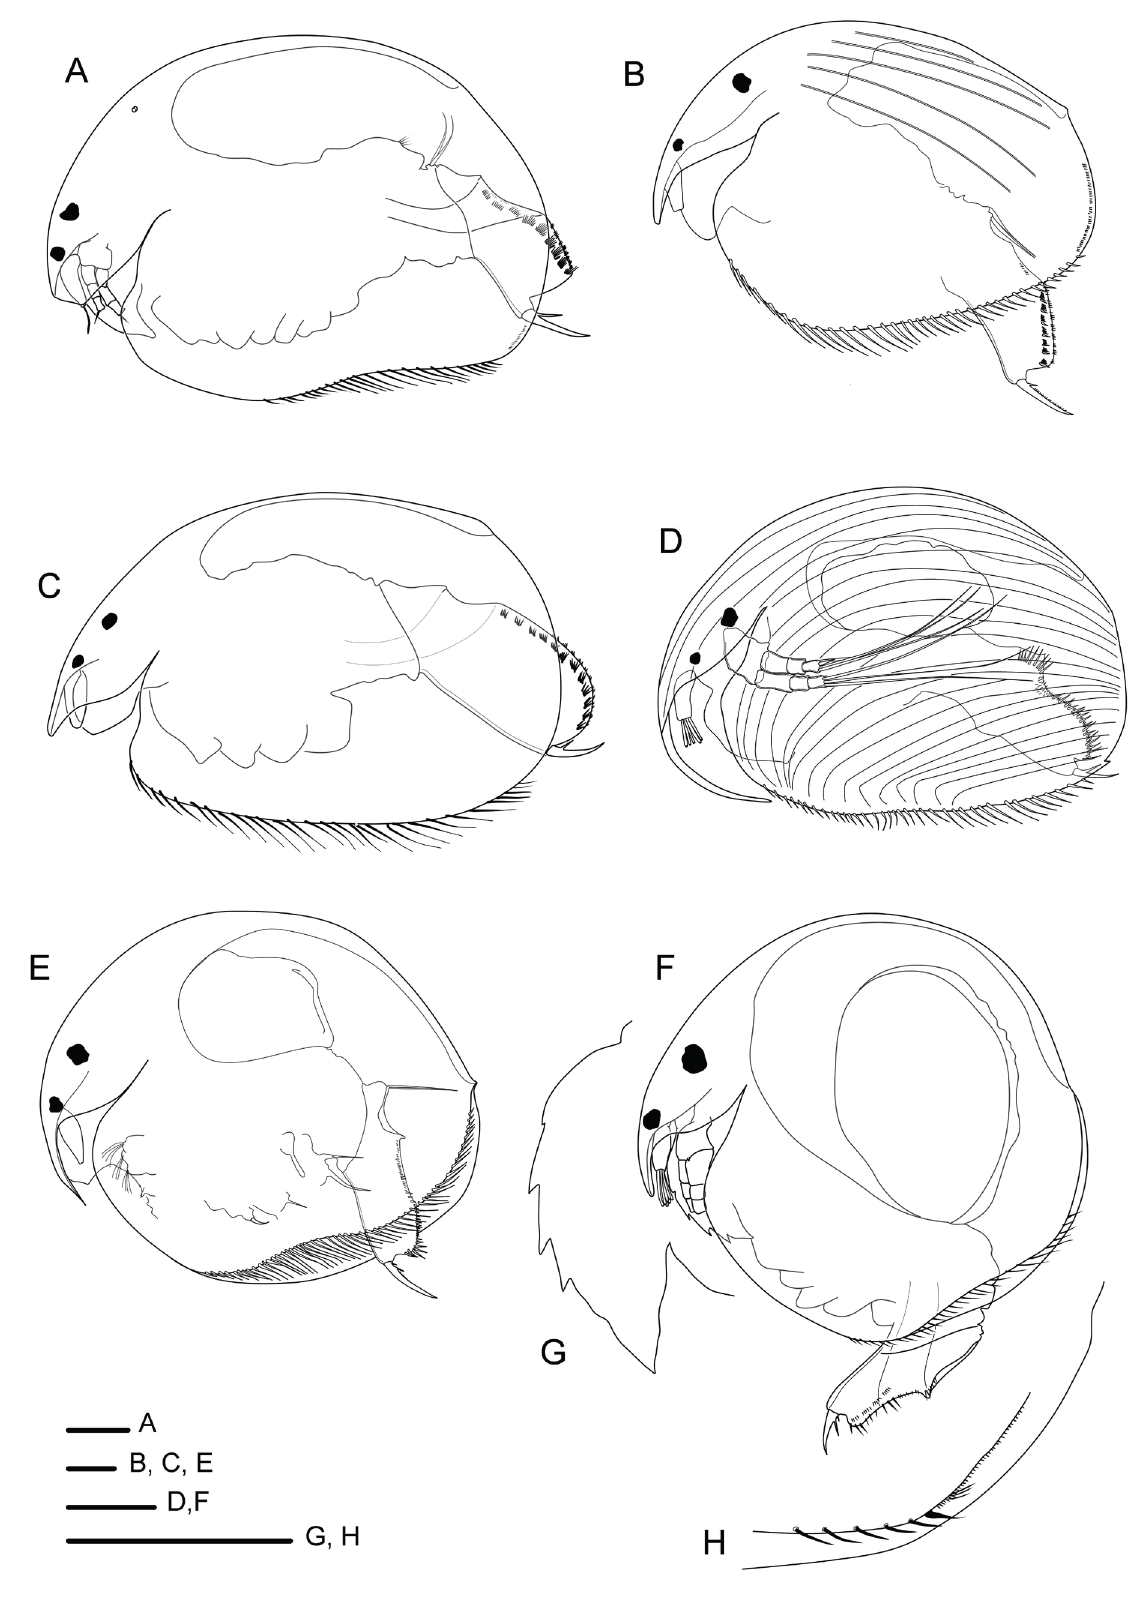
Figure 5. Parthenogenetic females from Lake Paranoá: A, Nicsmirnovius sp.; B, Notoalona sculpta ; C, Parvalona parva ; D, Alonella dadayi ; E, Chydorus eurynotus ; F, Ephemeroporus tridentatus ; G, idem , labral keel; H, idem , posteroventral corner of carapace. Scale bars = 50